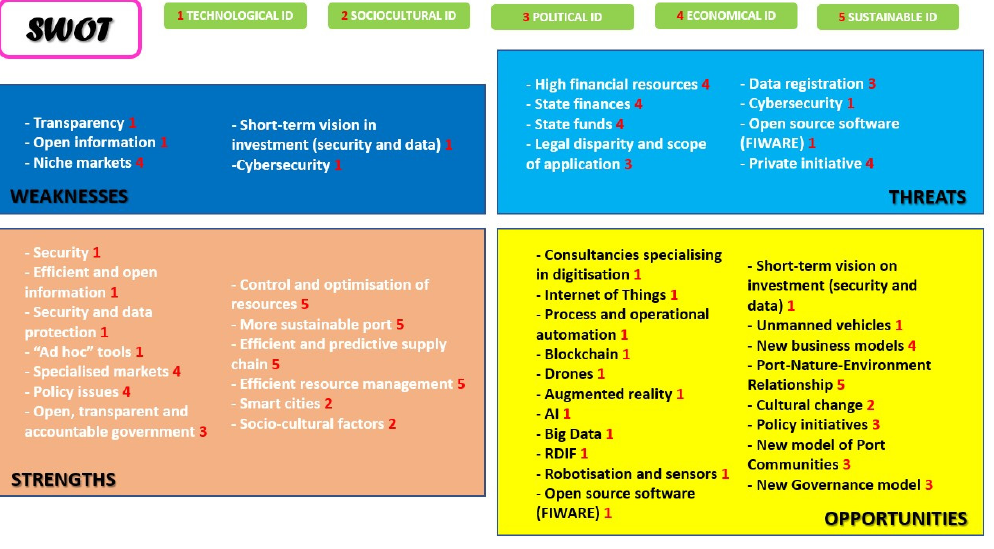
Figure 10. SWOT macro-environment. Source: own elaboration.